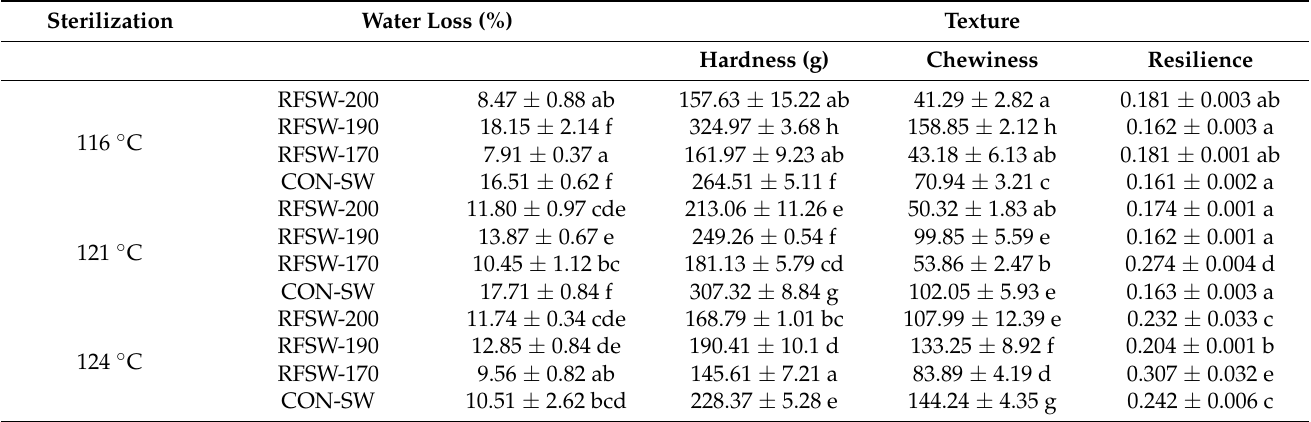
Table 3. Water loss and texture of PSPS sample sterilized by radio frequency combined superheated water in different electrode gaps and at different superheated water temperatures. RFSW means radio frequency combined superheated water at an electrode gap; CON-SW means superheated water sterilization